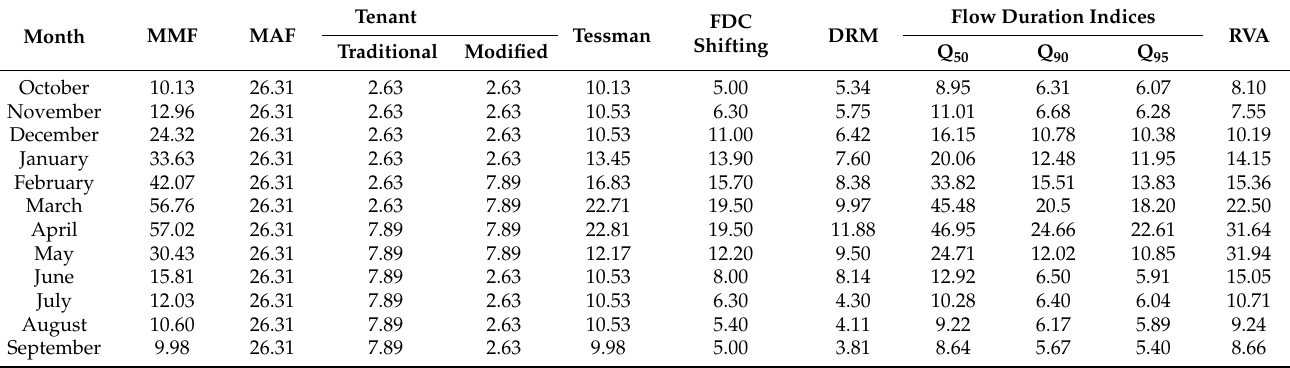
Table 3. Monthly distribution of EWR of the Kor River by different methods (m 3